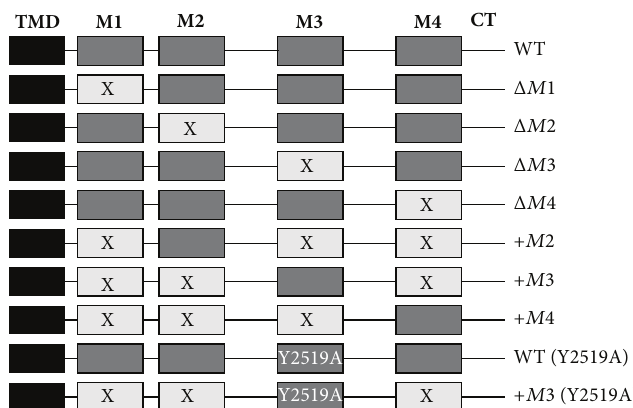
Figure 1: HARE CD mutants with different combinations of the four endocytic motifs. The diagram illustrates the various combinations of HARE CD motifs ( M1, M2, M3, and M4 ) present (dark gray boxes) or deleted (light gray boxes with X) in the panel of stable HARE-CD variant cell lines used here. The single transmembrane domain (TMD, black box), C-terminal region (CT), and presence of the site-specific Y2519A mutation in M3 are